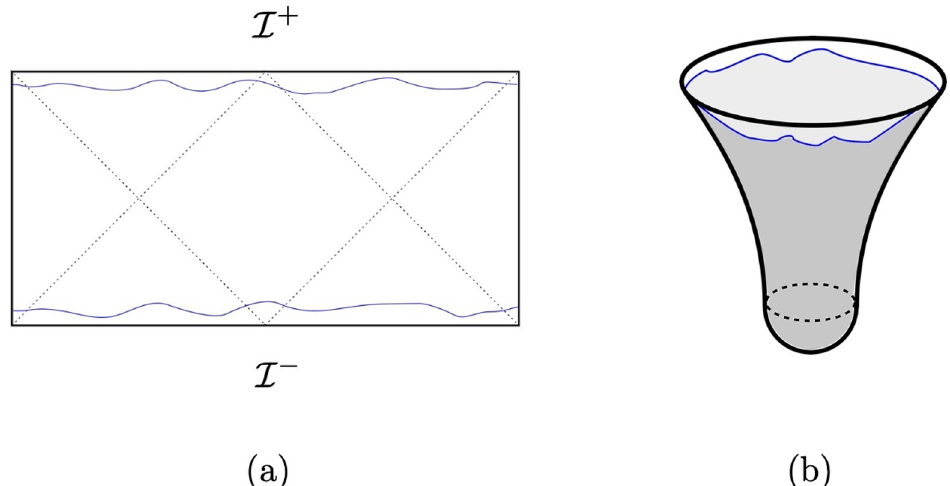
Figure 1 . (a) The Penrose diagram for global dS 2 with (cid:11) = 1. In our analysis we consider (cid:13)uctuating Cauchy surfaces (depicted as blue curves) near past and future in(cid:12)nity. The left and right boundaries are identi(cid:12)ed. The geometries with (cid:11) < 1 are \squashed" horizontally, while those with (cid:11) > 1 are \stretched." (b) A cartoon of the geometry used in the Hartle-Hawking construction. The Lorentzian and Euclidean segments are glued together across the circle. The (cid:13)uctuating boundary is indicated in